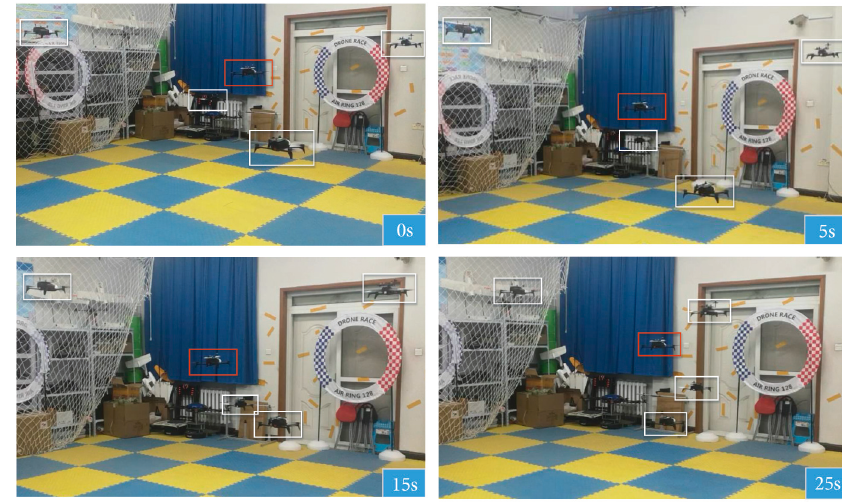
Figure 14: Flight geometries of the quadrotors.